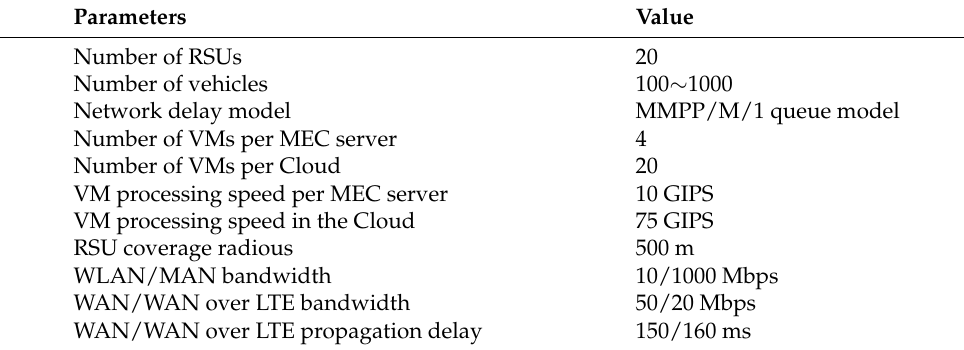
Table 2. Simulation